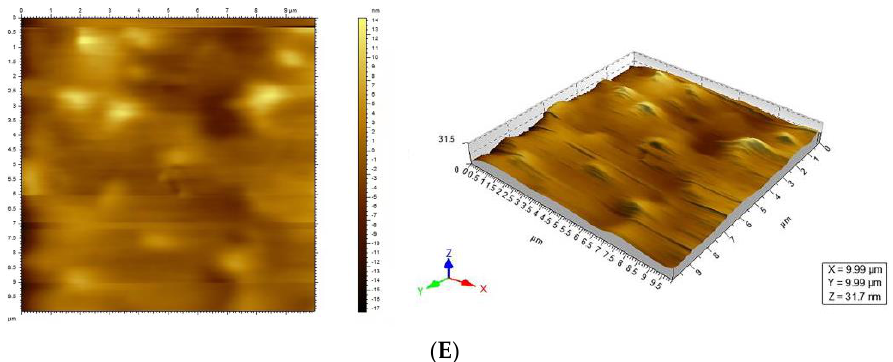
Figure 12. AFM of different Si Ti ratio coatings (( A – E ) in turn correspond to the SiO 2 -TiO 2 content ratio of 1:1, 1:2, 1:3, 1:5, 0:1). According to the analysis of the atomic force photos of the coating, the flatness of the coating surface was excellent. The surface roughness of the coating changed at the range of 3.27 – 4.55 nm with the shifty content of nano-TiO 2 in the film-forming material, as shown in Figure 13.